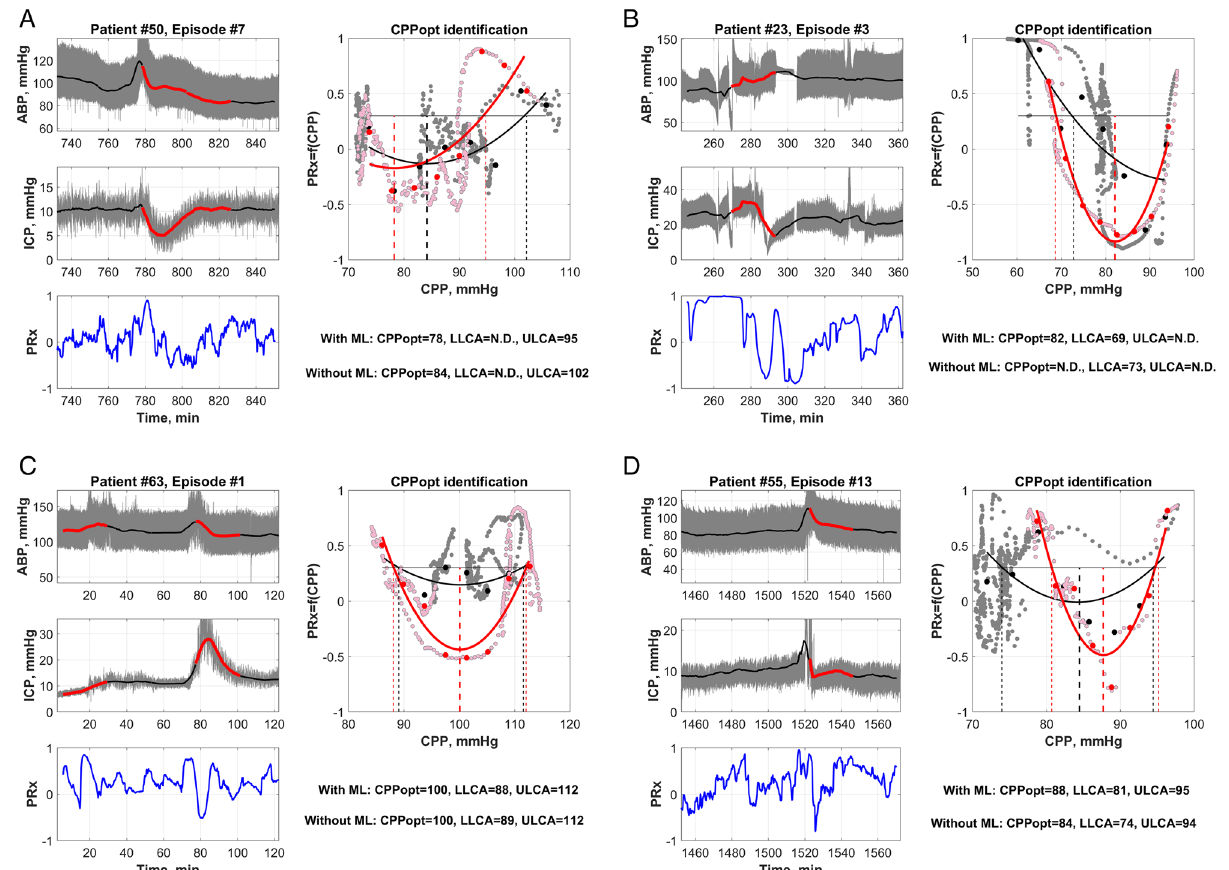
Figure 4. Examples of CPPopt identification according to informative ABP and ICP episodes (marked in red). The PRx = f(CPP) graph demonstrated the contribution to informative data points (pink) and noninformative data points (gray) to the formation of the U-shape approximation and CPPopt identification results. The red curve in the PRx = f(CPP) graph represents the U-shape approximation when ML is applied, and the black curve is the approximation when ML is not applied. These results show that short informative episodes (20–30 min) with informative physiological ABP and ICP data changes are sufficient to obtain the U-shape and identify the CPPopt value. ( a )—Without ML (black color) CPPopt = 84 mmHg, LLCA is not detected and ULCA = 102 mmHg. With the ML algorithm (red color) CPPopt = 78 mmHg, LLCA not detected and ULCA = 95 mmHg. ( b )—Without ML (black color) CPPopt is not detected, LLCA = 73 mmHg and ULCA is not detected. With the ML algorithm (red color) CPPopt = 82 mmHg, LLCA = 69 mmHg and ULCA is not detected. ( c ) Without ML (black color) CPPopt = 100 mmHg, LLCA = 89 mmHg and ULCA = 112 mmHg. With the ML algorithm (red color) CPPopt = 100 mmHg, LLCA = 88 mmHg and ULCA = 112 mmHg. ( d ) Without ML (black color) CPPopt = 84 mmHg, LLCA = 74 mmHg and ULCA = 94 mmHg. With the ML algorithm (red color) CPPopt = 88 mmHg, LLCA = 81 mmHg and ULCA = 95 mmHg. Here ND is “not